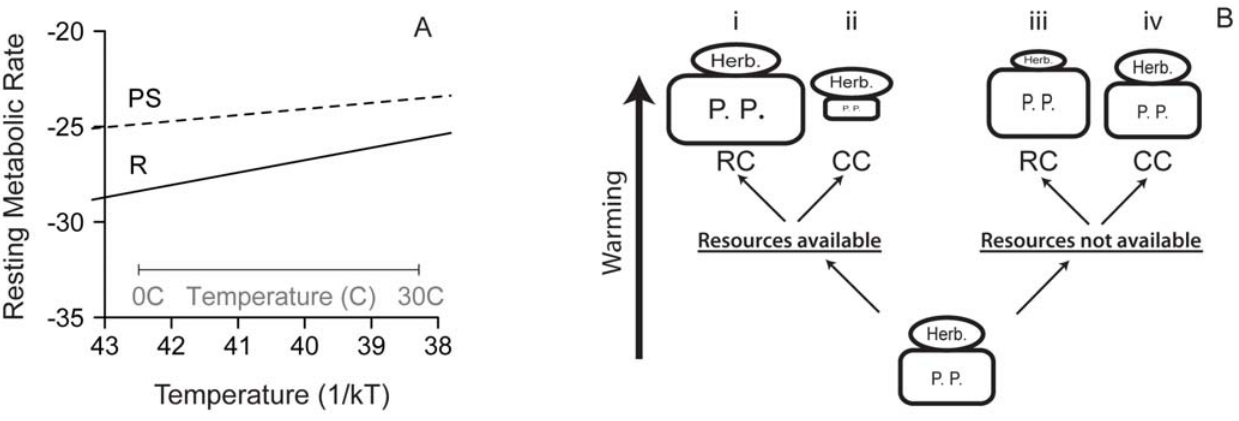
Figure 1. Effects of temperature on metabolism and food web structure. (A) Temperature (1/kT for T in Kelvin) dependence of photosynthesis- (PS, slope= 2 0.32 eV) and respiration- (R, slope= 2 0.65 eV) based mass-normalized resting metabolic rate (mmol O 2 /d pg C a h ) (Adapted from Allen et al., 2005 [10], Lopez-Urrutia et al., 2006 [9]). (B) Four possible effects of warming on food web structure and biomass depend on resource availability and the importance of consumer-controlled (CC) or resource-controlled (RC) food web dynamics. Relative size of boxes and ovals indicate standing biomass stocks for the simplest of food webs comprising herbivores (Herb.) and primary producers (P. P.).